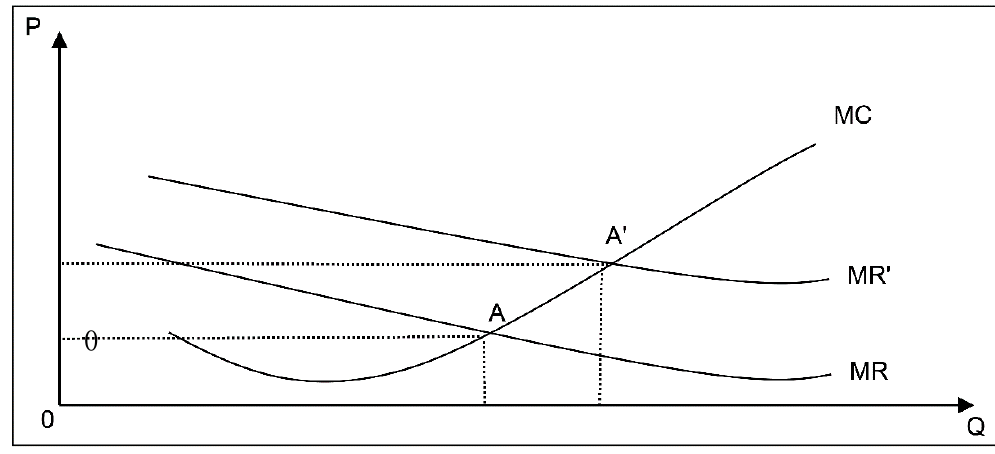
Figure 2. Marginal cost and revenue analysis of commercial bank loans when green credit increases.